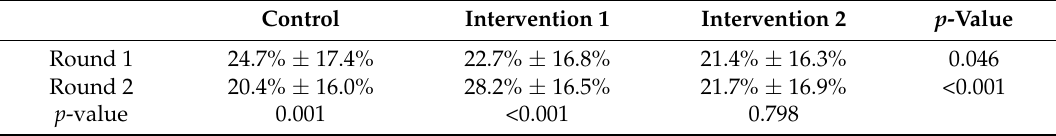
Table 2. DDI-related performance by intervention arm and round: Diagnosis-treatment domain